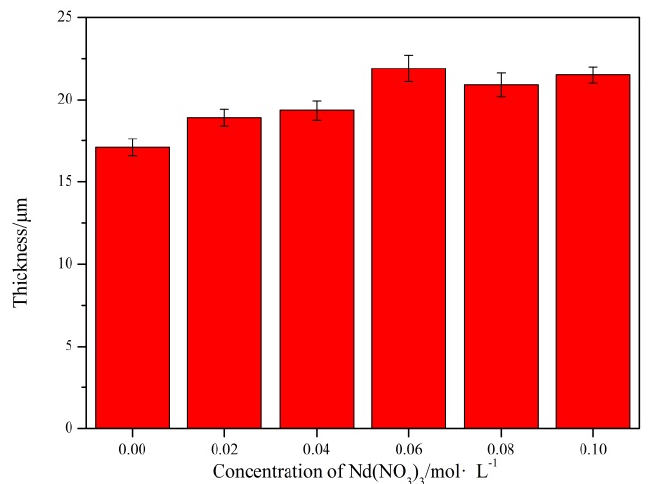
Figure 3. The thickness of MAO coatings.